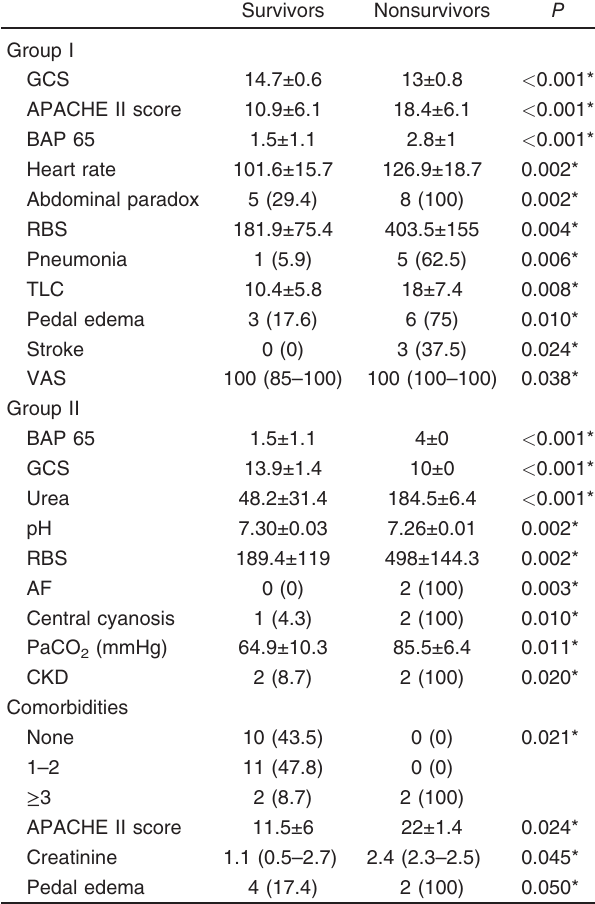
Table 15 Predictors of mortality on univariate analysis of patients in both studied